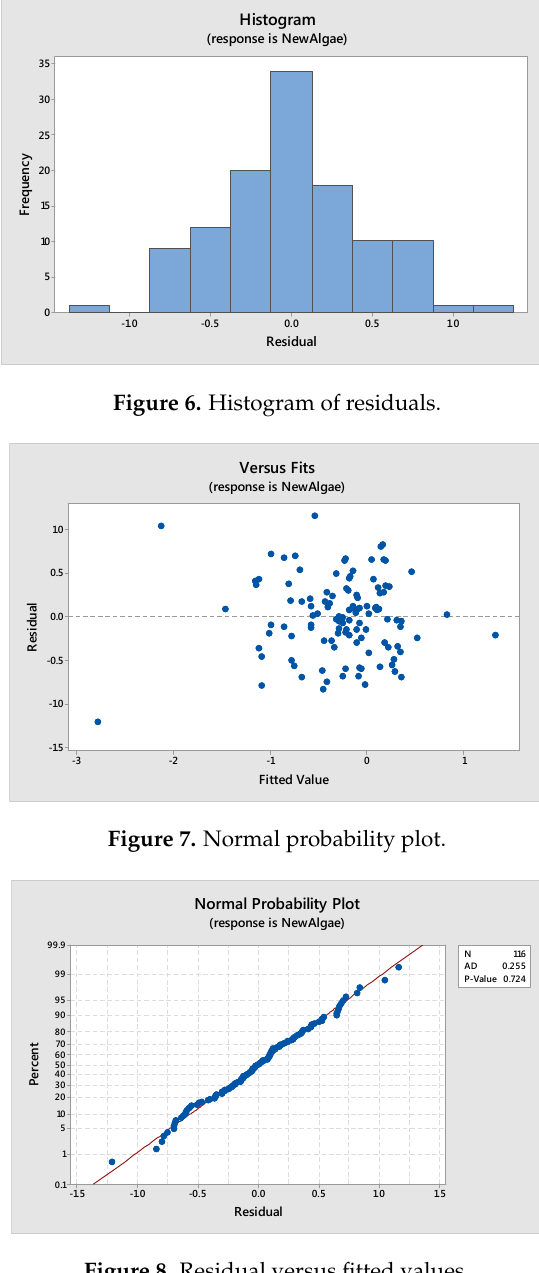
Figure 8. Residual versus fitted values.